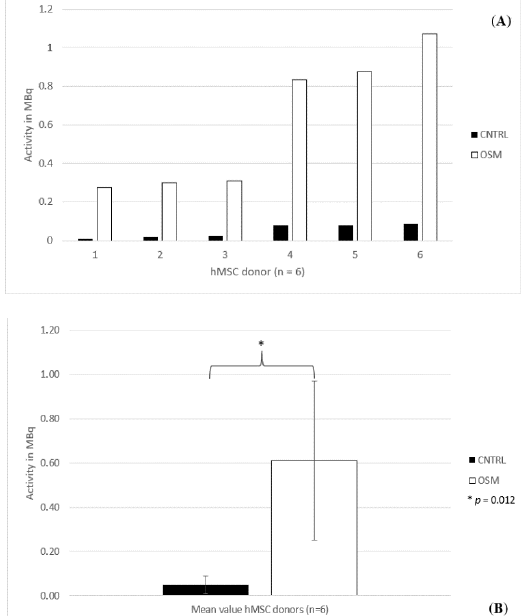
Figure 4. ( A ) Individual activity bound to each dish for donors 1–6 treated in osteogenic media (OSM) and the negative control group (CNTRL) measured by 18 F-activimeter analysis. ( B ) Mean activity ( n = 6 ) bound to the dishes in osteogenic media (OSM) and the negative control group (CNTRL) measured by 18 F-activimeter analysis, +/ − standard deviation, p = 0.012; * = significant difference between the two groups, p ≤ 0.05.